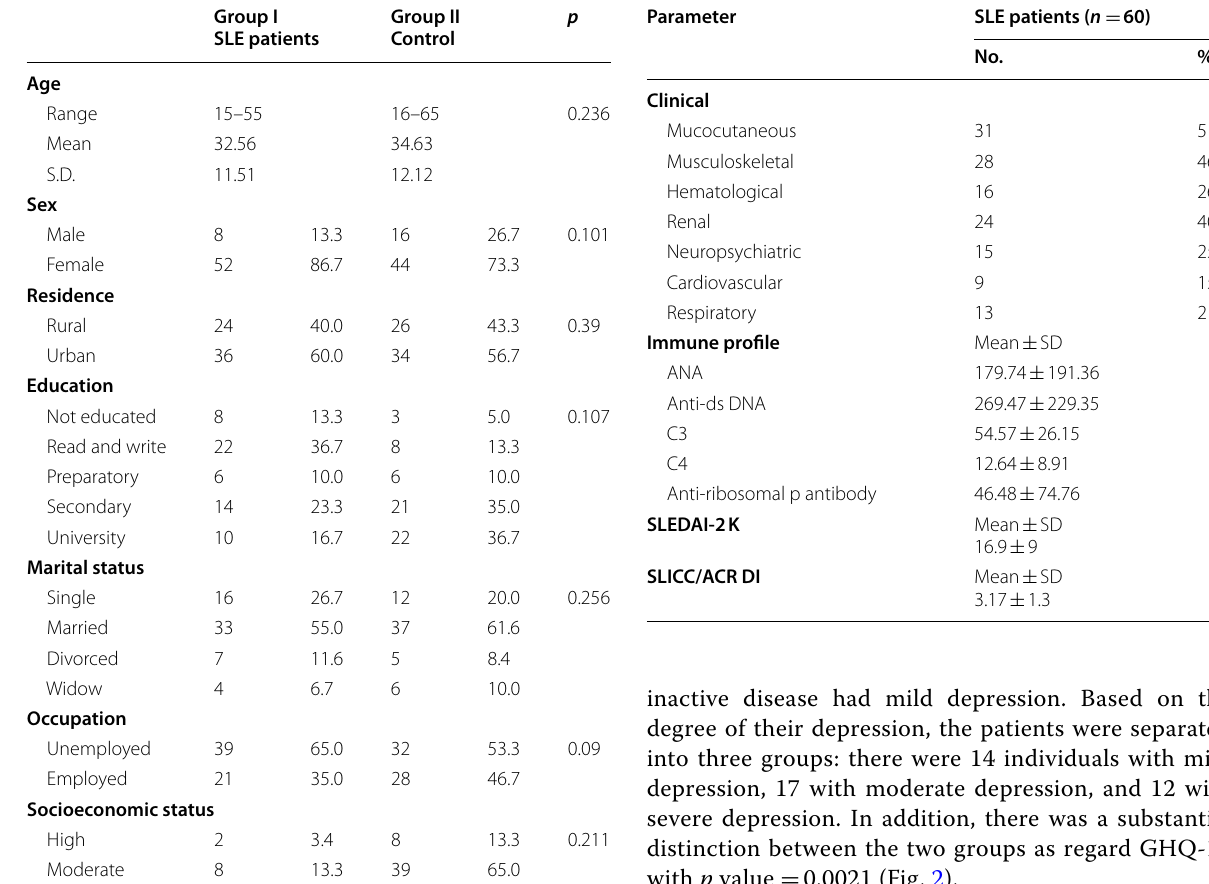
Table 2 Clinical characteristics, immune profile, and